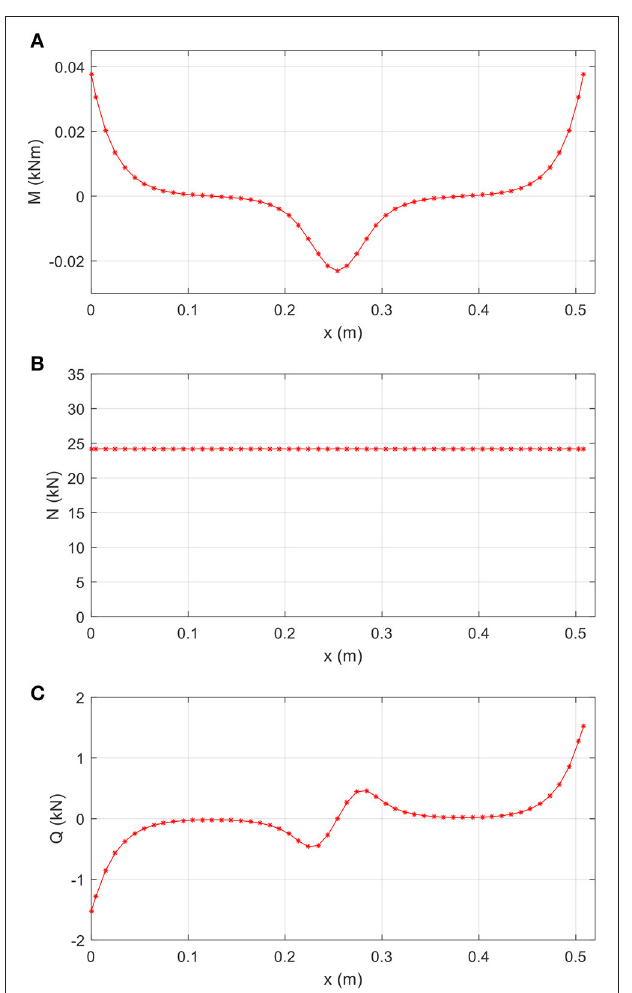
FIGURE 6 | Profile of the (A) bending moment, (B) axial force, and (C) shear force in Example 1.